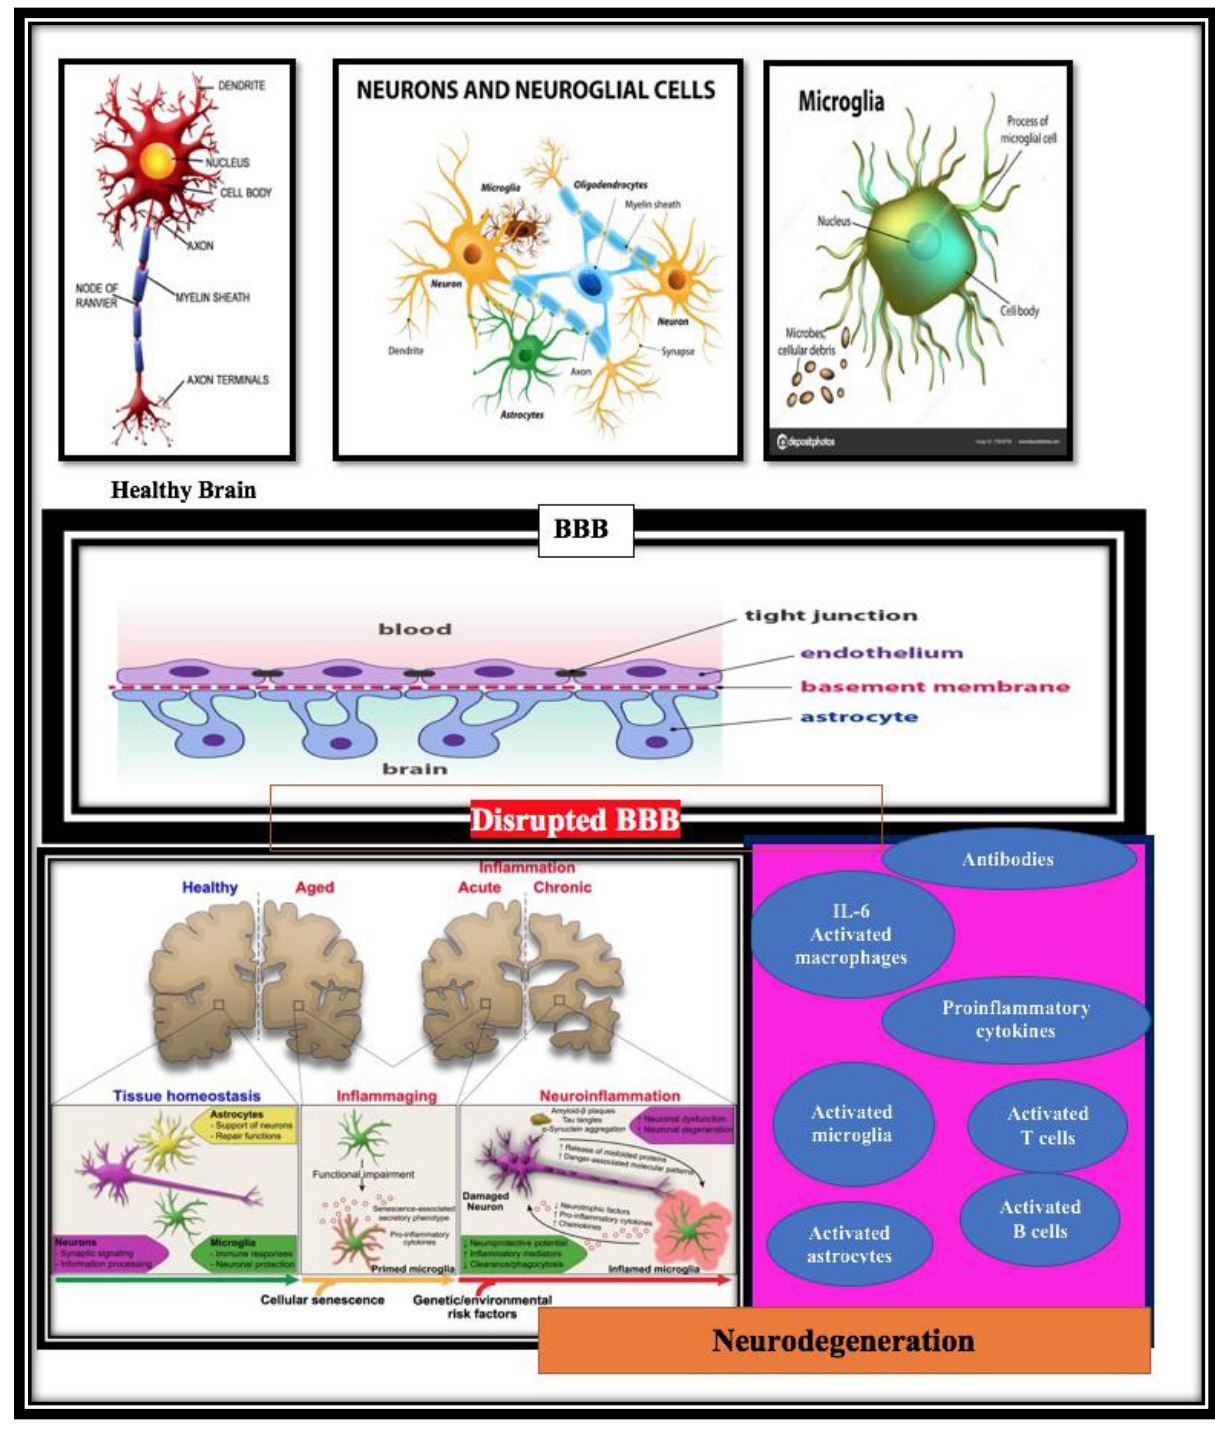
Figure 2. Relationship between the central nervous system (CNS) and systemic immune responses in Alzheimer ’ s disease (AD) patients.